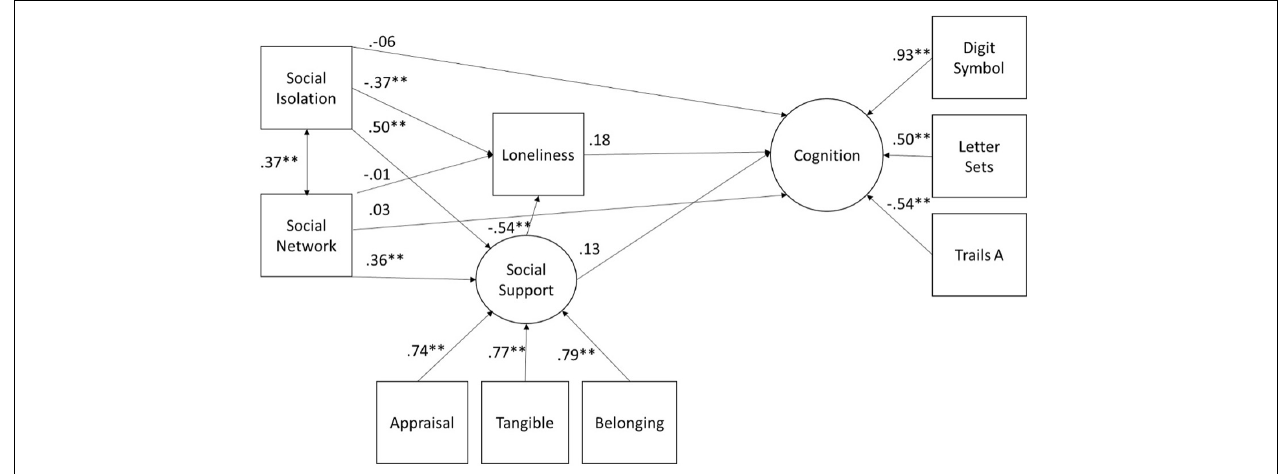
FIGURE 3 | SEM for latent Cognition for the full sample. All paths are denoted with the standardized beta. * p < 0.05, ** p <